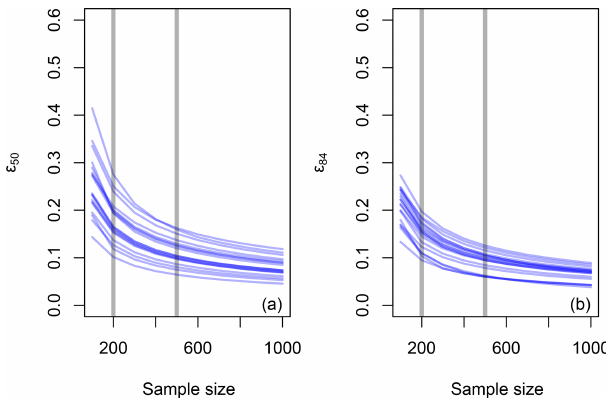
Figure 11. Estimated uncertainty for estimates of D 50 (a) and D 84 (b) are plotted against sample size for a simulated set of log- normal surface distributions with a range of sorting indices. The markers are color-coded by si φ . The bounding curves for si φ = 1 and si φ = 5 . 0 are shown for reference, calculated using Eqs. (6) and (8). Table 1. Coefficient values for estimating uncertainty in D 50 and D 84 as a function of si φ using Eqs. (6) and (8).